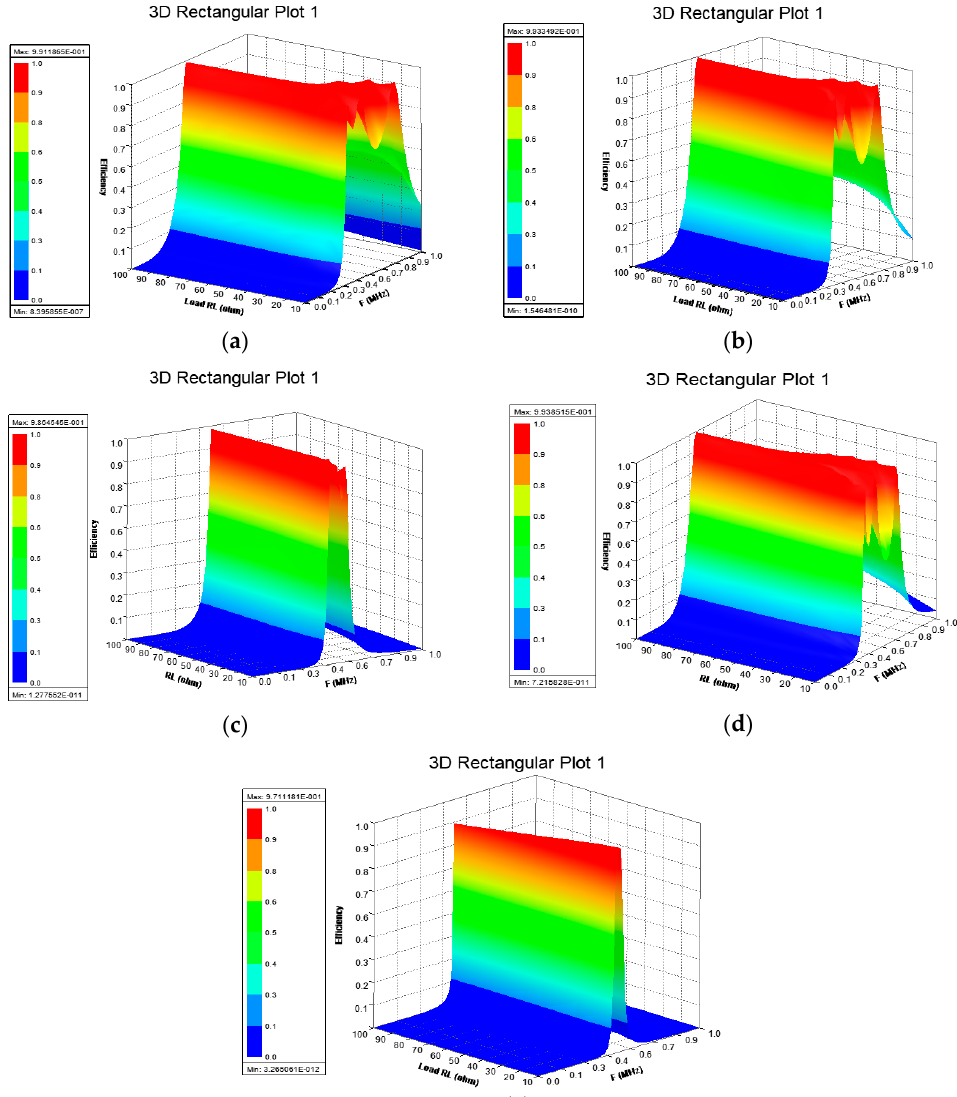
Figure 12. The relationship between efficiency, load, and resonant frequency: ( a ) equator windings; ( b ) hemisphere windings; ( c ) double layer windings; ( d ) modified hemisphere windings; ( e ) optimal model.